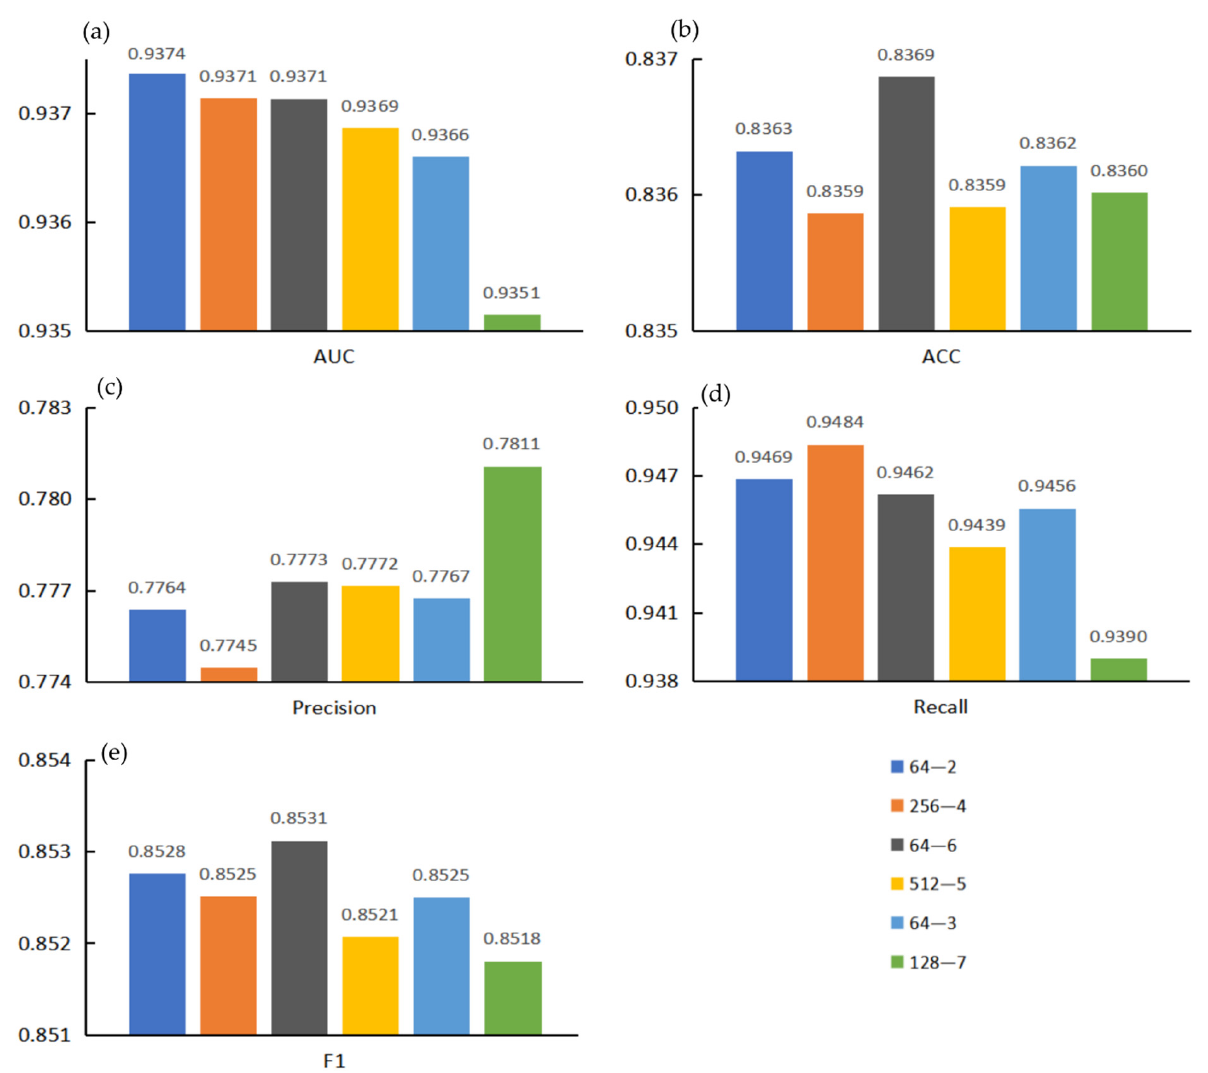
Figure 6. The top five evaluation indicators were marked and summarized to obtain two or more models. ( a ) AUC value comparison; ( b ) ACC value comparison; ( c ) Precision value comparison; ( d ) Recall value comparison; ( e ) F1 value comparison.